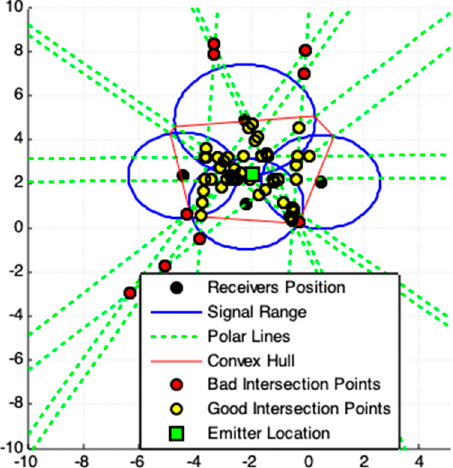
better applying the exact solution provided by Section 2.1.